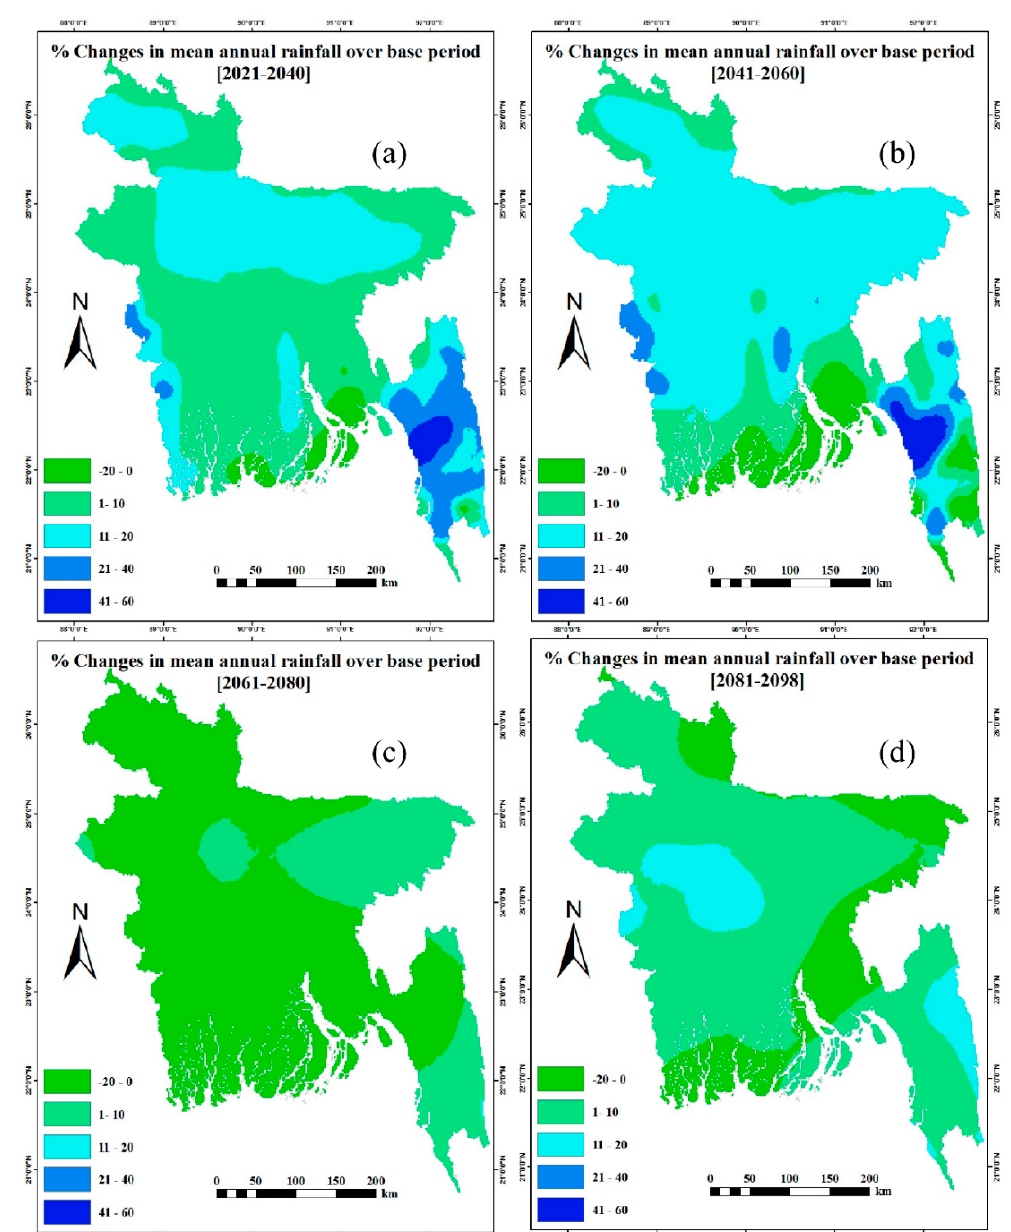
Figure 6. Double mass curve of annual maximum rainfalls at Dinajpur ( left ) and Mymensingh ( right ) of the base period (1986–2005).